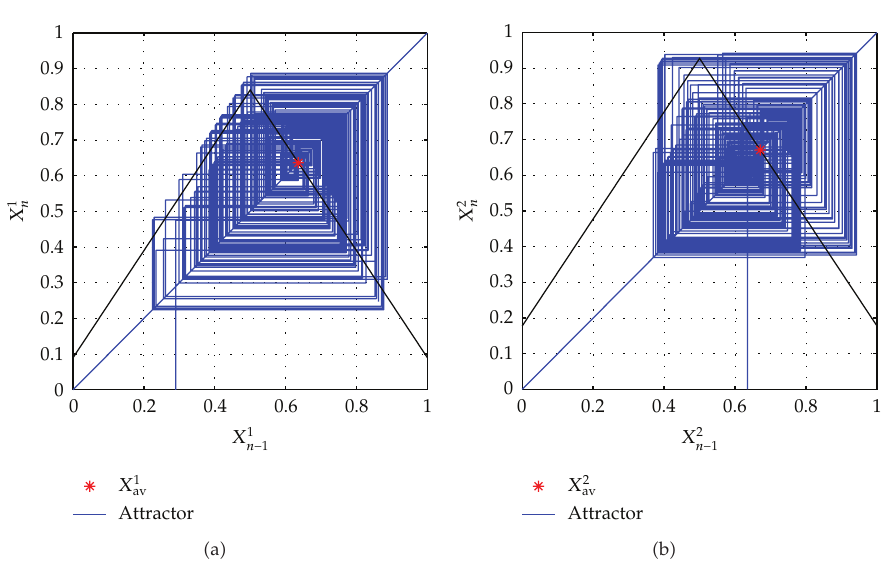
Figure 8: Attractor diagram with the average fixed point (cid:2) X 1